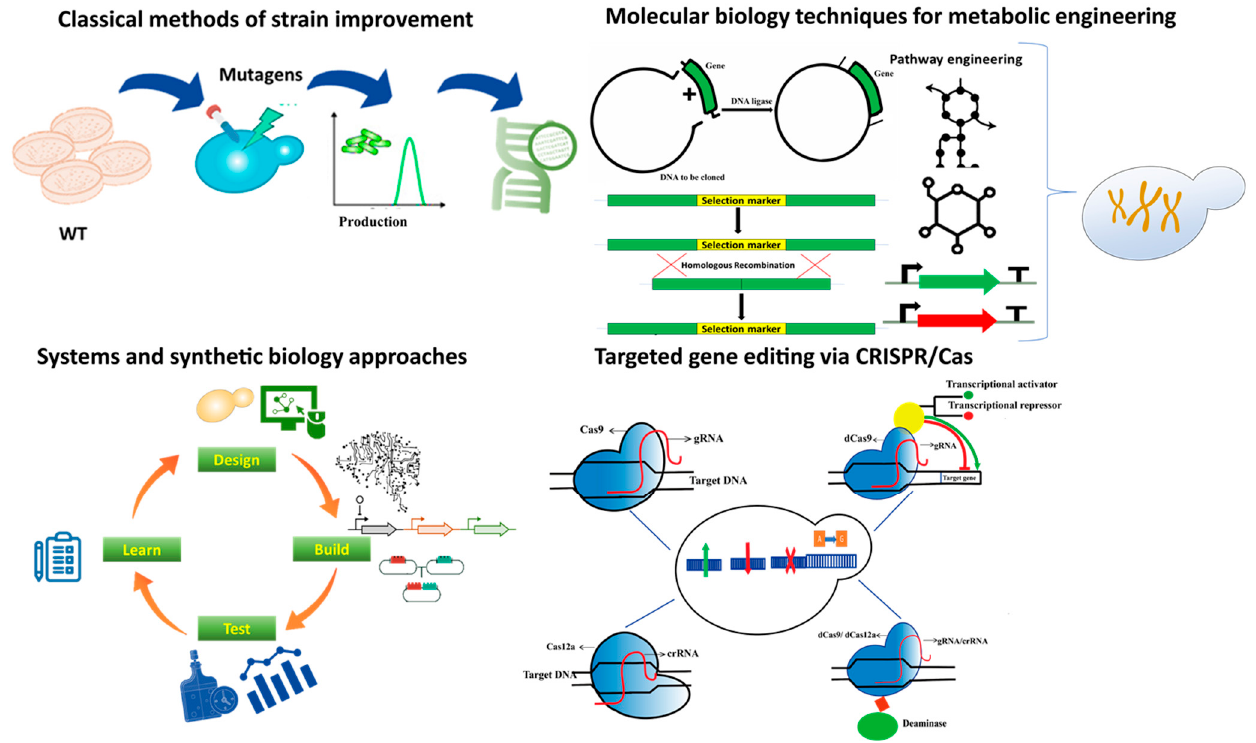
Figure 3. Summary of technologies used in metabolic engineering ranging from classical methods to the state of the art advanced technologies.